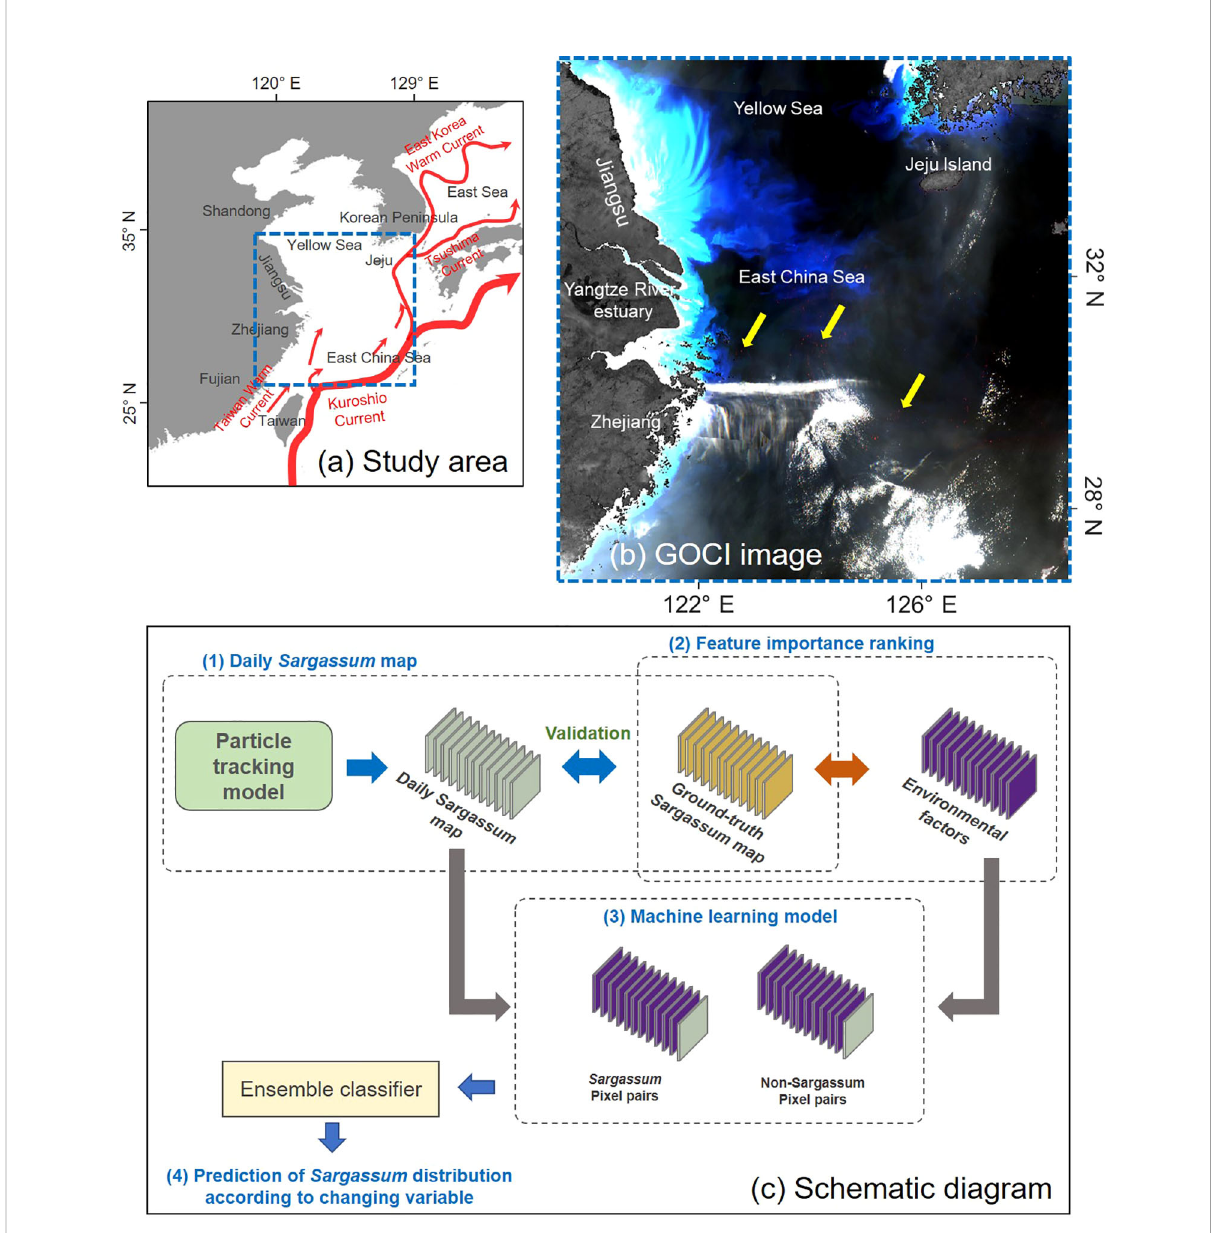
FIGURE 1 Study area and schematic diagram in this study. (A) The study area covers the East China Sea (ECS) and the southern Yellow Sea (YS) including Jeju Island in Korea. (B) Rayleigh-corrected re fl ectance (R hoC ) pseudo-color composite image generated from Geostationary Ocean Color Imager (GOCI) acquired on April 23, 2017 at 02:16 UTC. The patch in red is recognized as Sargassum (yellow arrow). (C) Schematic showing the relationship between Sargassum distribution and environmental factors. There are the four steps are: (1) The daily Sargassum maps were generated using ground-truth Sargassum data and particle tracking model, (2) feature importance ranking was performed for investigating the importance between environmental factors affecting Sargassum distribution, (3) machine learning model was trained and tested for predicting Sargassum distribution through environmental factors, and (4) Sargassum distribution was predicted according to changing environmental variables using the machine learning